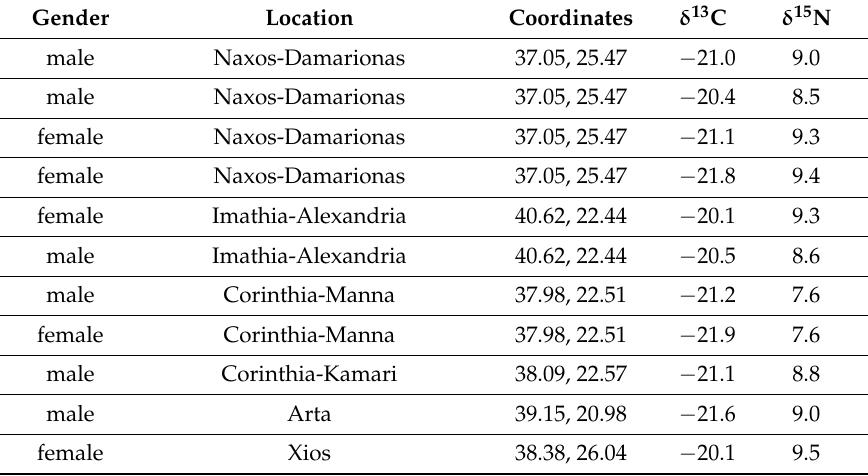
Table 2. Isotopic values of contemporary humans from